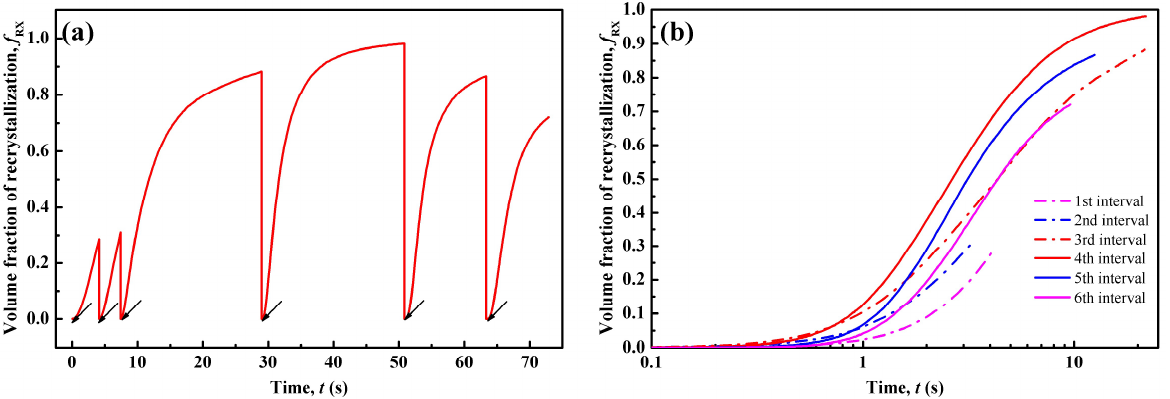
Figure 5. CA-simulated volume fraction of recrystallization varying with time: ( a ) an overview of the 6-pass hot-rolling process and ( b ) in each pass. Arrows in ( a ) indicate the end of each pass.